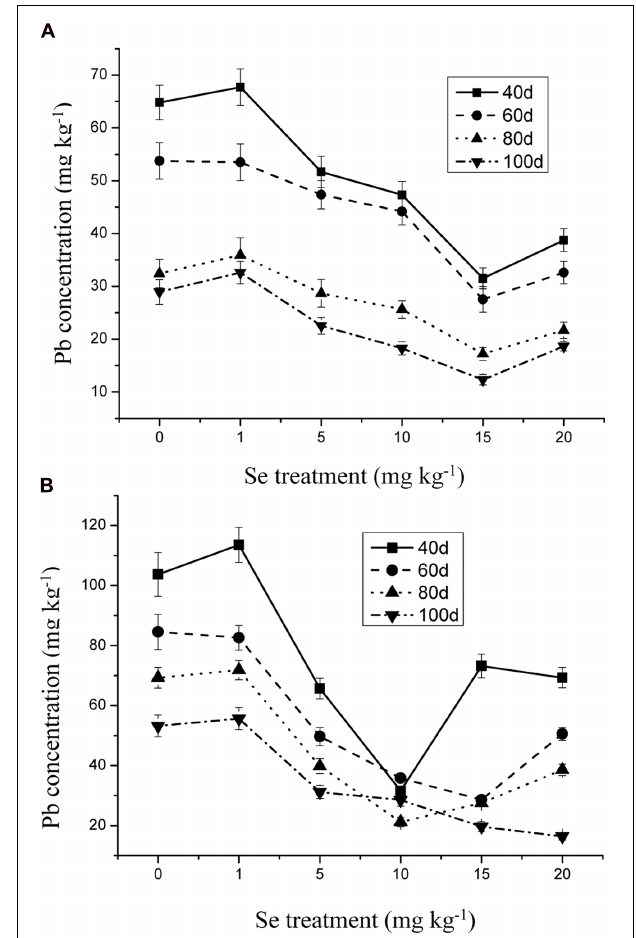
FIGURE 2 | (A) Concentration of Pb in shoots of oilseed rape treated with soil Se and 300 mg kg − 1 Pb in different periods. (B) Concentration of Pb in shoots of oilseed rape treated with soil Se and 500 mg kg − 1 Pb in different periods. Average concentrations (Dry biomass weight, DBW) provided with error bars representing the standard error. ( p ≤